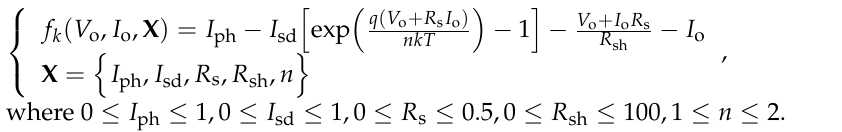
Table 17. Comparison results for the parameter identification of SDM.